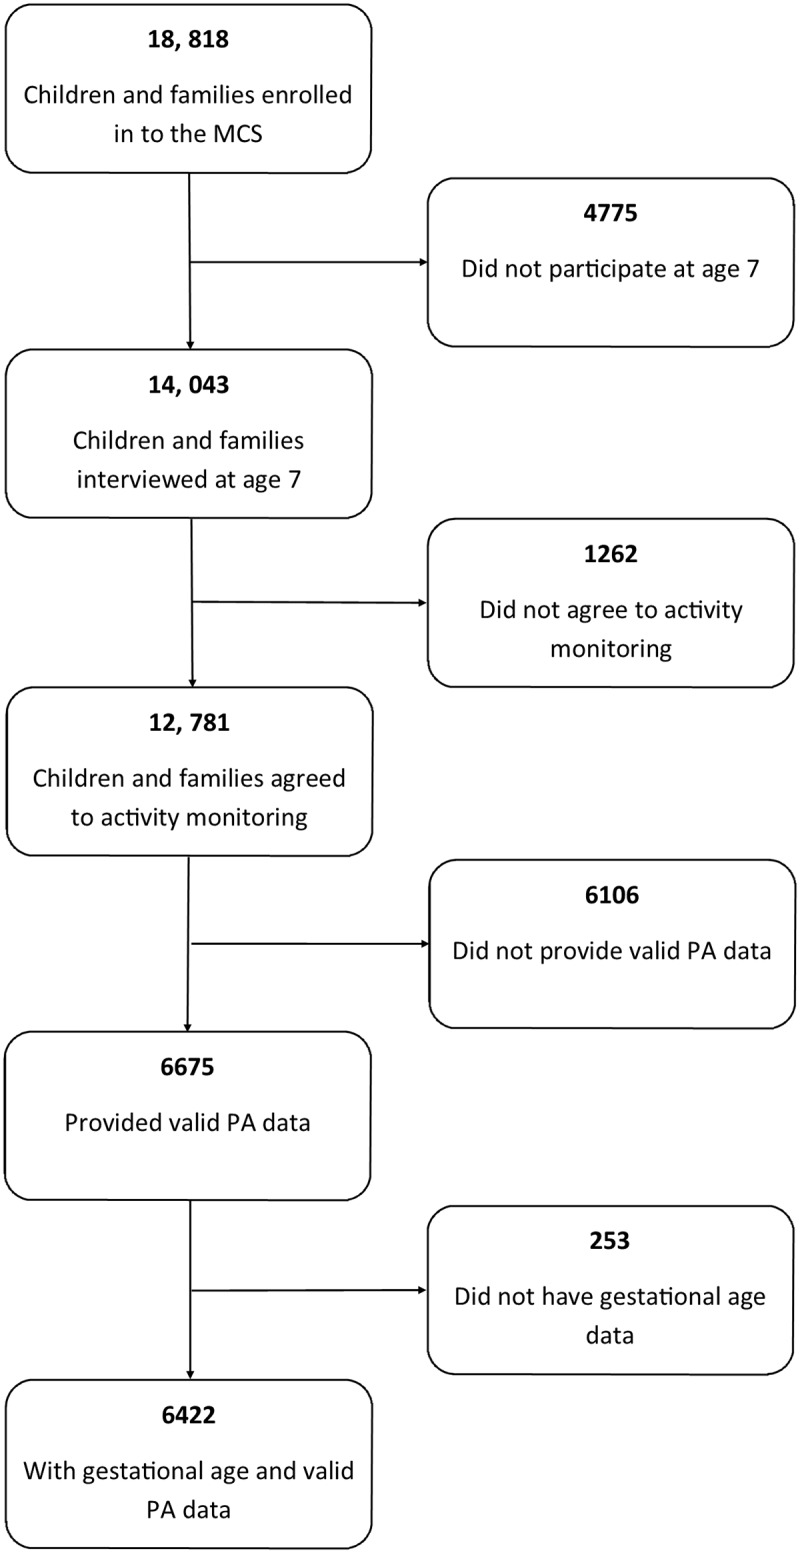
Flow diagram of MCS participants with available PA and gestational age data at age 7.